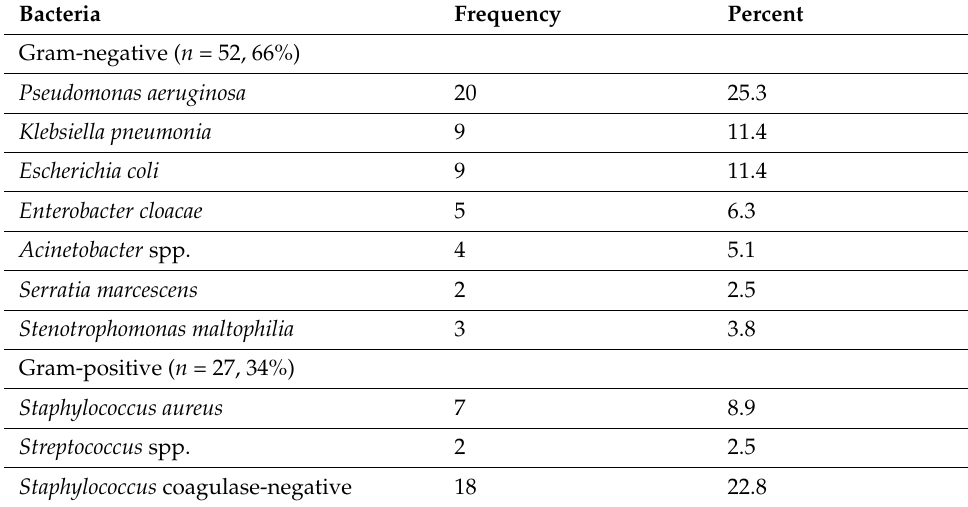
Table 3. Pathogenic bacteria causing neonatal